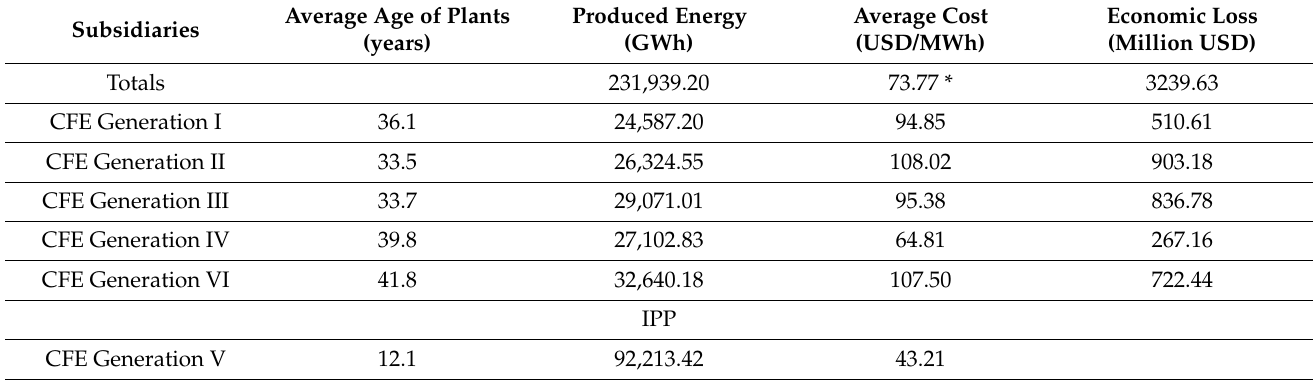
Table 4. Seniority and average cost (2015 constant, USD) of CFE subsidiaries in 2019. * Weighted average cost includes IPP. Subsidiaries